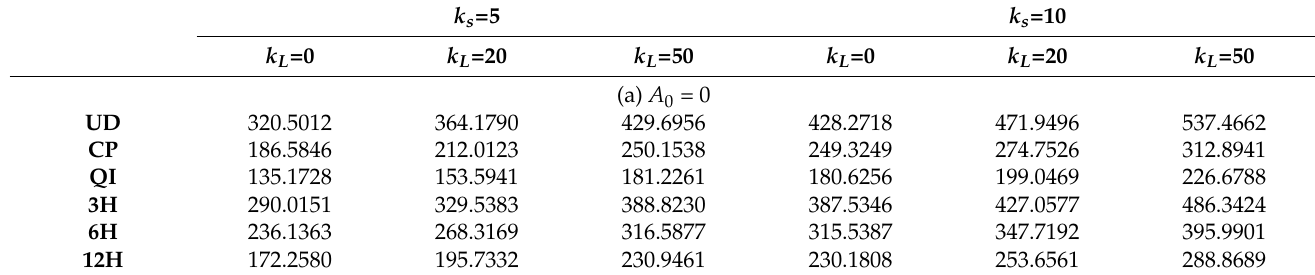
Table 5. First critical buckling loads ( N ) of perfect and imperfect composite beams for different layups, L = 100 h